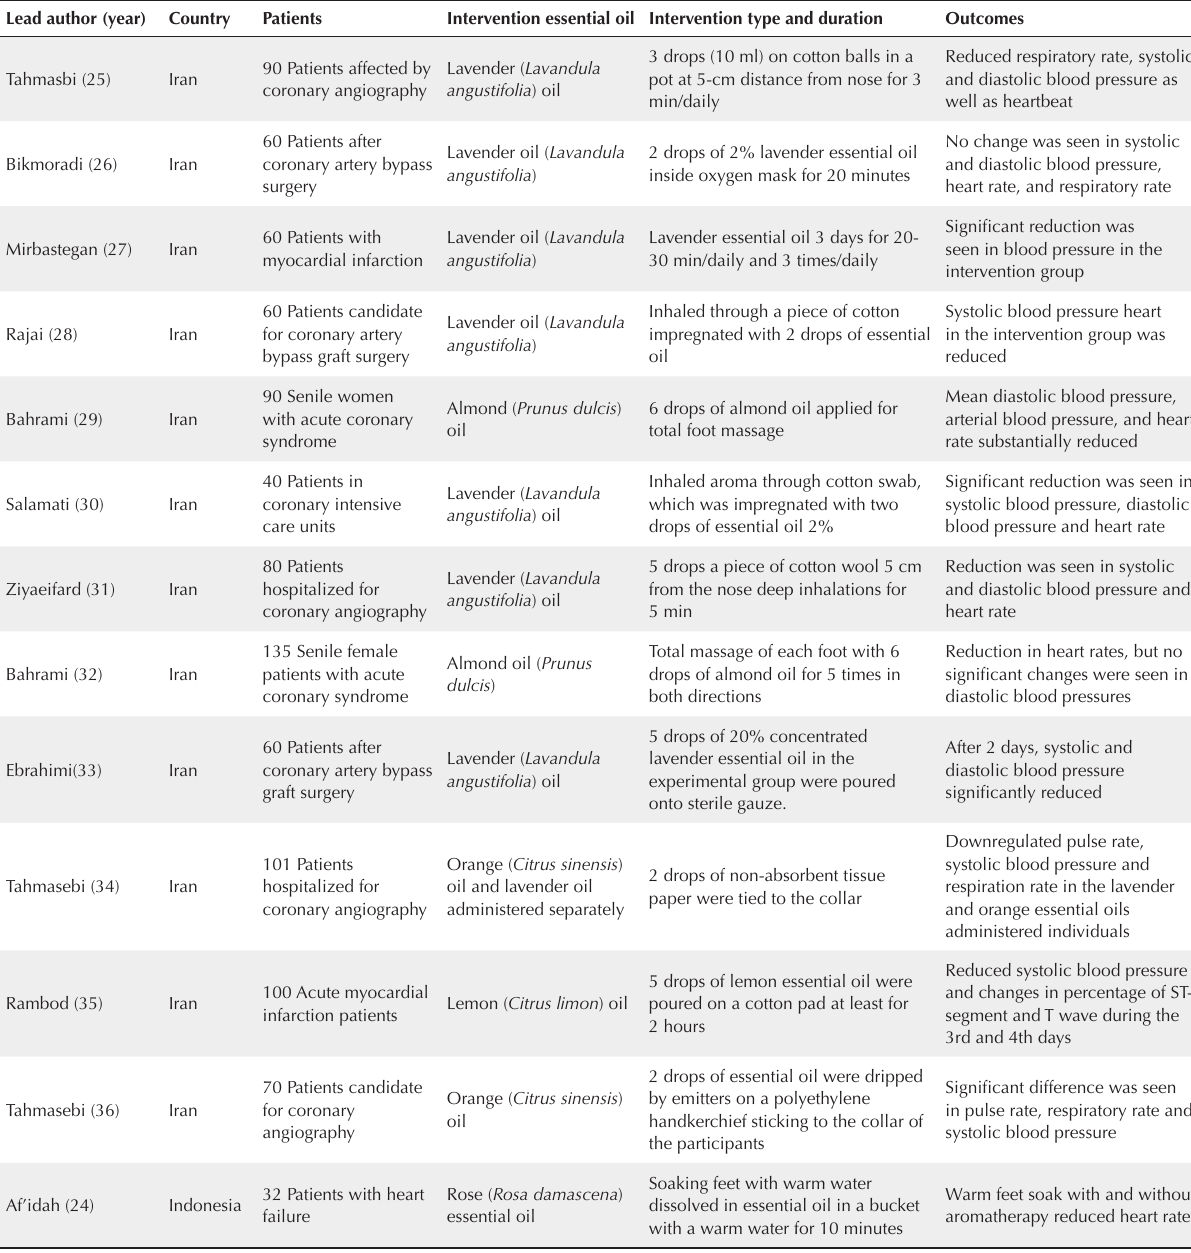
Table 1. Characteristics of randomized clinical trials on aromatherapy used in regulating hemodynamic parameters Lead author (year)